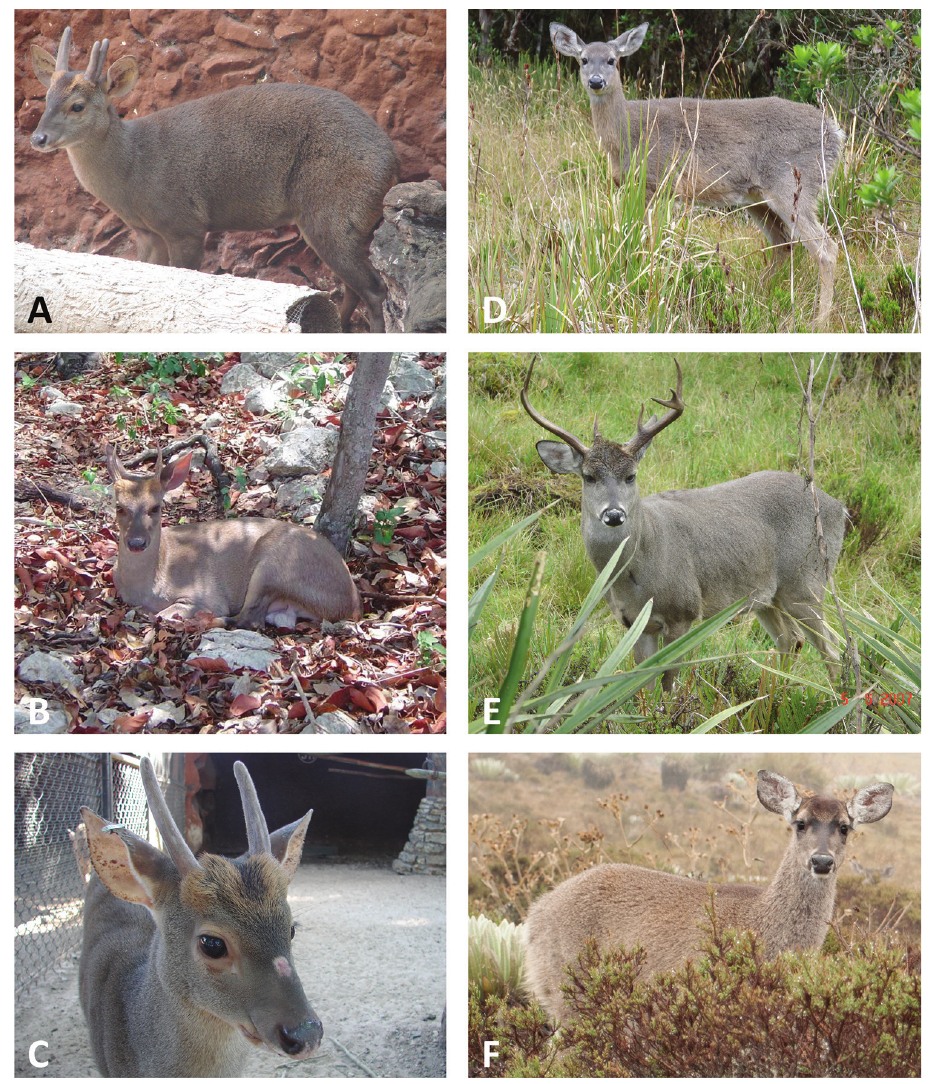
Figure 2. Overall morphological appearance of “ M.” pandora (panels A–C ) and that of the genus Odoc- oileus (panels D–F ). Notice the grayish pelage and divergent antlers larger than in other species currently classified in Mazama . “ M.” pandora , panels A and C individuals kept in captivity at the Parque Zoológico del Bicentenario Animaya, Mérida, Yucatán, Mexico (photographs by Luis A. Escobedo-Morales)—prov- enance unknown; panel B individual kept in captivity in Tekax, Yucatán, Mexico (photograph by Rosa María González Marín)—provenance unknown. Odocoileus virginianus (see proposals by Molina and Molinari 1999 and Molinari 2007); panels D and E Monteredondo, Parque Nacional Chingaza, ca. 47 km (by road) E Bogota, Cundinamarca, Colombia (photographs by Aideé Vargas-Espinoza and Irene Aconcha, respectively); panel F Laguna de Mucubají, Parque Nacional Sierra Nevada, Mérida, Venezuela (photograph by Rodrigo Díaz